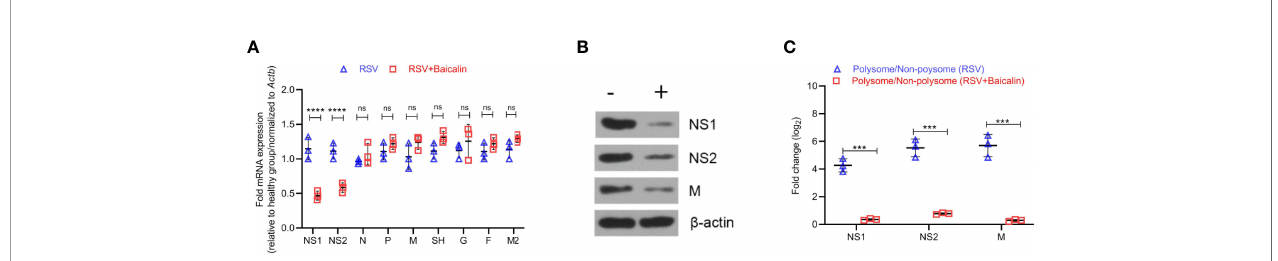
FIGURE 4 | Baicalin affects transcriptional and translational regulation of RSV gene products. (A) Baicalin causes the downregulation of viral genes NS1 and NS2, but not others. Expression of indicated viral transcripts in lung homogenates of RSV-infected mice ± baicalin was quanti fi ed by RT-qPCR. Outcomes were normalized to Actb . (B) Immunoblot analysis of NS1, NS2, and M protein in lung homogenates of RSV-infected mice ± baicalin showed downregulation in the expression of these proteins after treatment with baicalin. Representative blots from 3 animals are shown. b -actin was immunobloted as a loading control. (C) Polysome occupancy of NS1, NS2, and M RNAs. Baicalin caused translational downregulation of viral M RNA. The decrease in polysome occupancy observed for NS1 and NS2 is attributable to the decrease in their total RNA. Data shown in (A , C) represents mean ± SD (n = 5); *** P < 0.001, **** P < 0.0001, ns , not signi fi cant – ANOVA with Tukey ’ s post-hoc test.